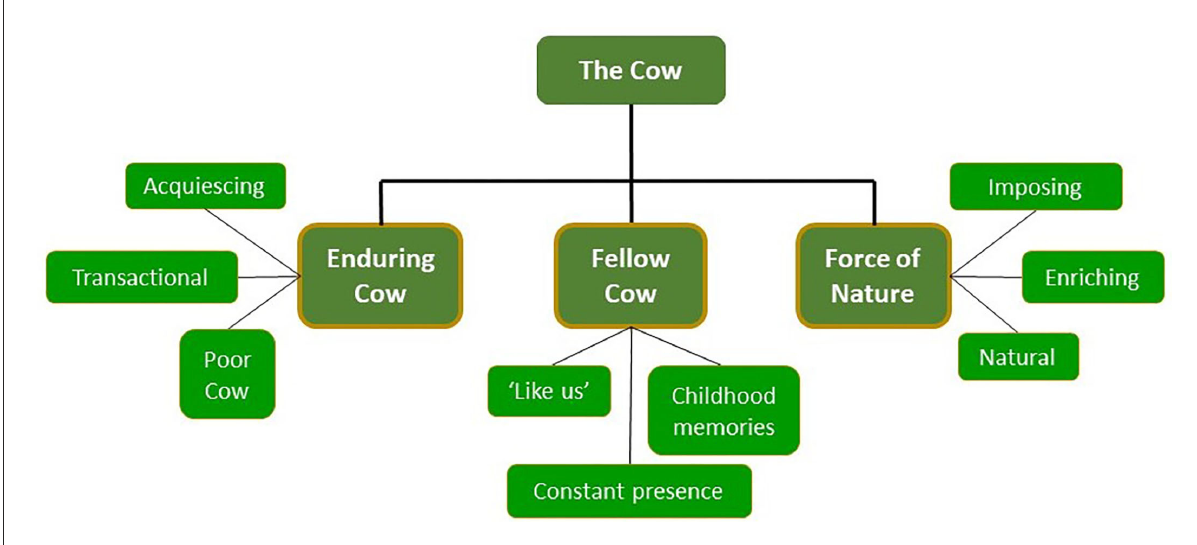
FIGURE1 Summary of the different frames developed for the cow, and underlying “narratives” through which each frame was